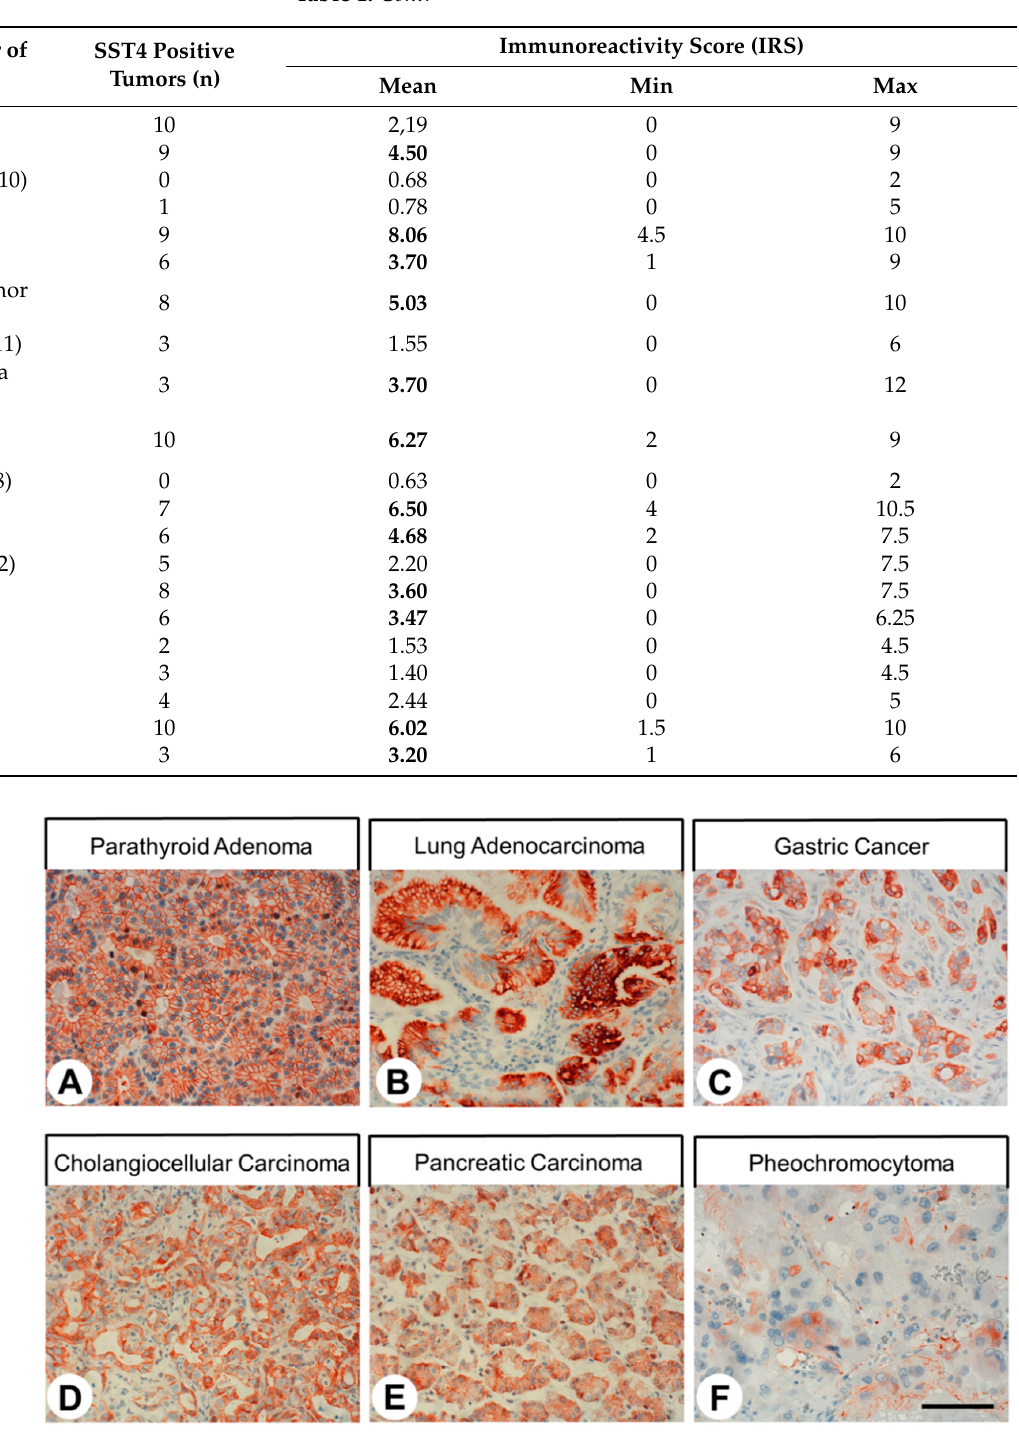
Figure 6. SST4 expression in different neoplastic human tissues. SST4 was detected immunohistochemically in sections of